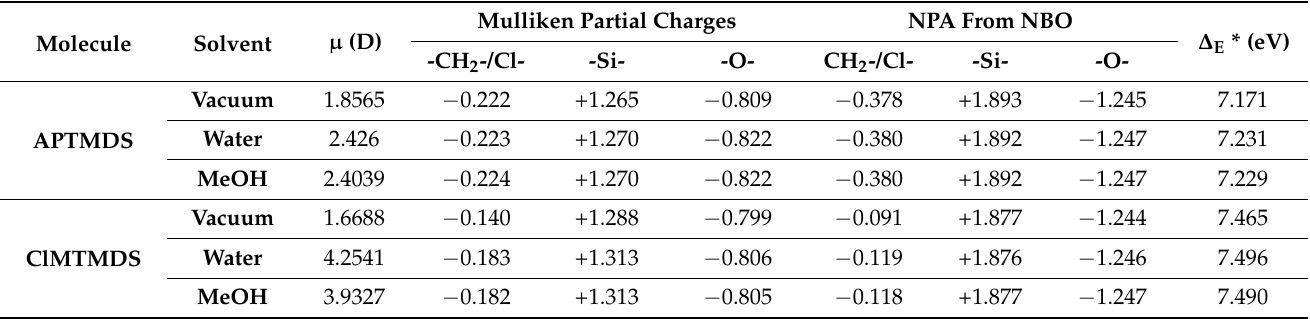
Table 5. Calculated data for APTMDS (with CH 2 in the β position) and ClMTMDS (with Cl in the β